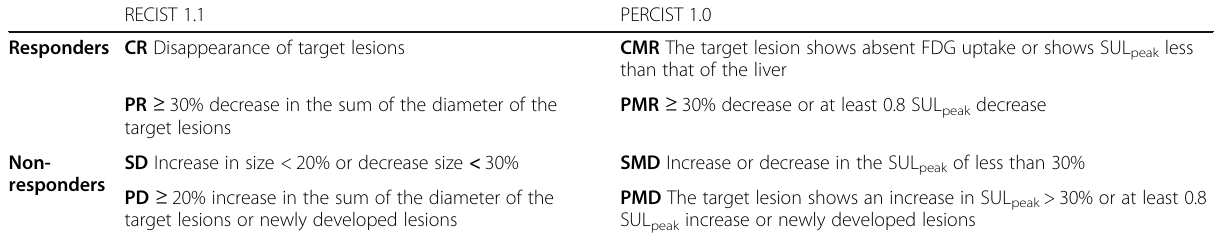
Table 1 RECIST 1.1 and PERCIST 1.0 criteria used for therapeutic response evaluation RECIST 1.1